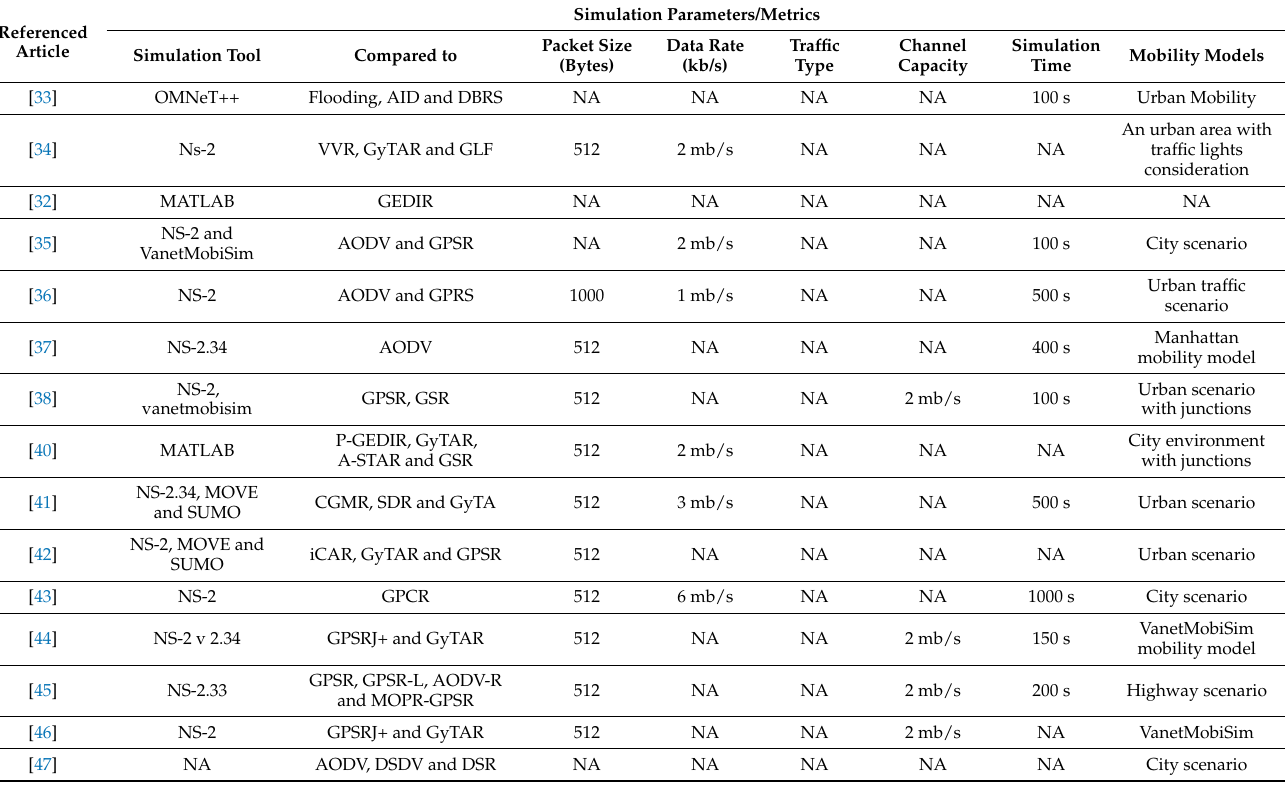
Table 9. Simulation parameters of urban scenario with traffic signals/traffic based routing protocols.